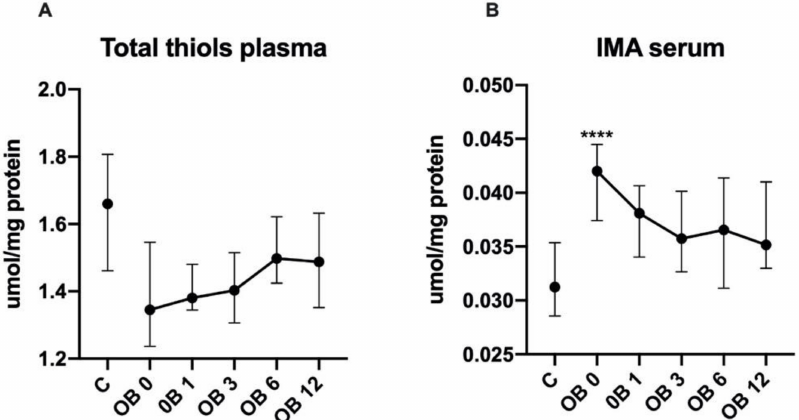
Figure 3. Plasma concentration of total thiols ( A ) and IMA ( B ) of the control (C) and morbid obesity (OB); Data given as median and 95% Cl; *** p < 0.001; morbidly obese patients before (OB 0), as well as 1 month (OB 1), 3 months (OB 3), 6 months (OB 6) and 12 months (OB 12) after sleeve gastrectomy; ischemia modified albumin